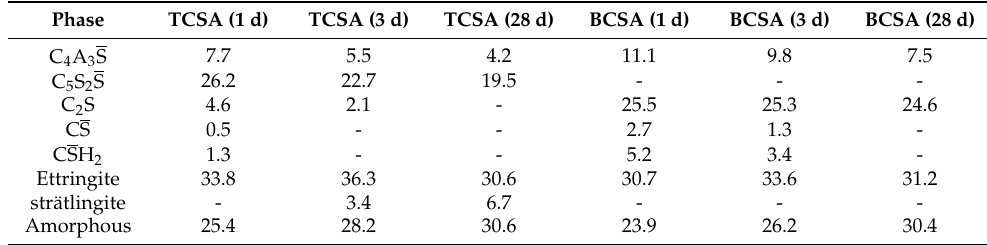
Table 10. Quantitative phase compositions of TCSA and BCSA cements